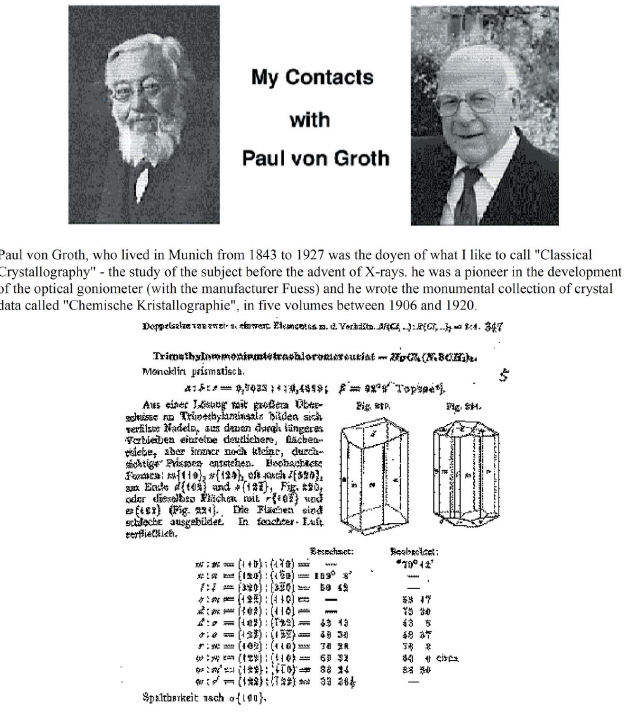
Figure 4 Linked page to Paul von Groth’s Historical Information.